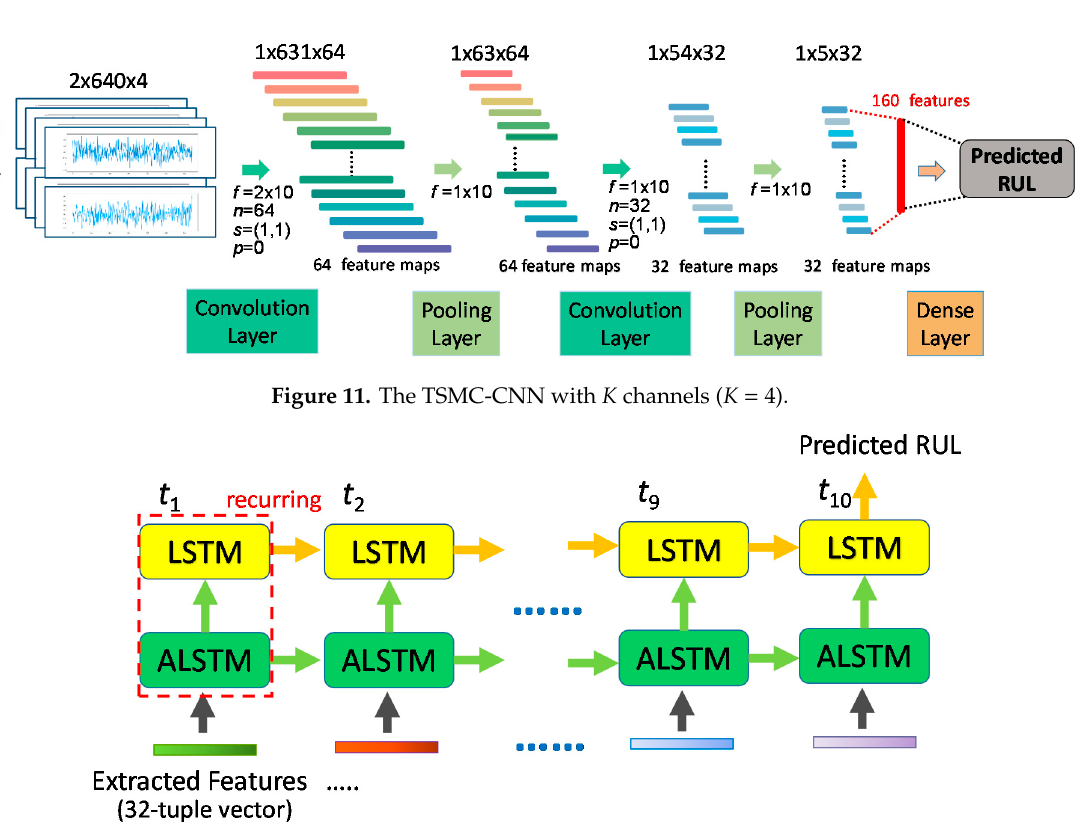
Figure 12. The ALSTM network adopted by the proposed TSMC-CNN-ALSTM method.